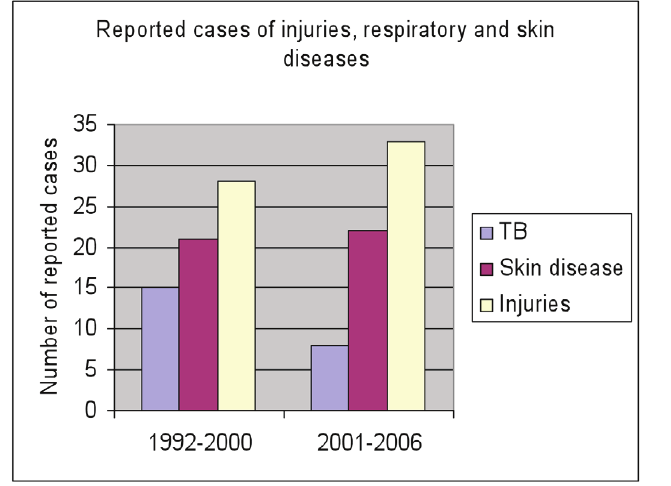
Figure 1: Reported cases of injuries, respiratory and skin diseases for the period